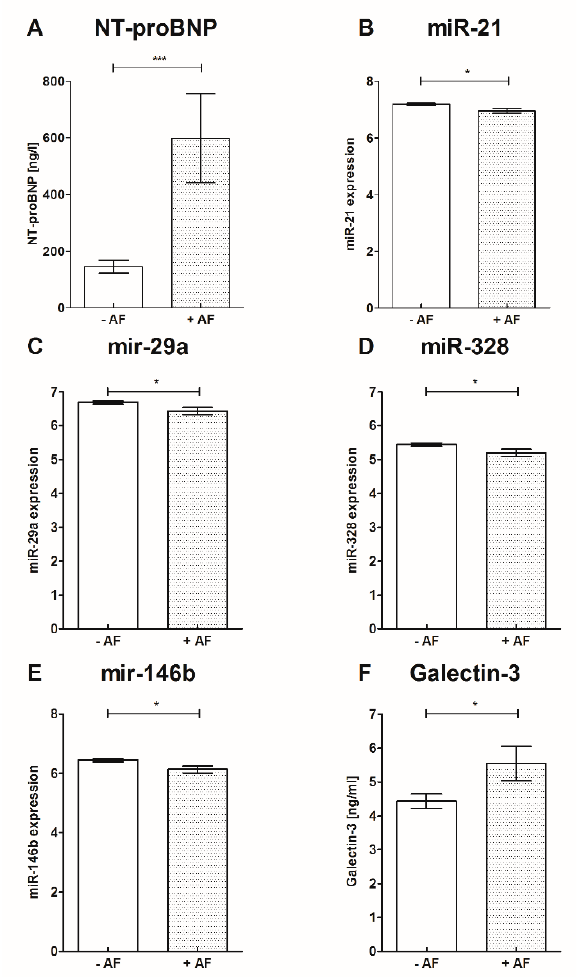
Figure 3. Biomarkers and miRs were altered in patients with and without AF. A : NT-proBNP, B : miR − 21, C : miR − 29a, D : miR − 328, E : miR − 146b, F : Galectin − 3 mean ± SD; * p < 0.05, *** p < 0.001; miR- Micro ribonucleic acid, NT-proBNP- N-terminal pro-brain natriuretic